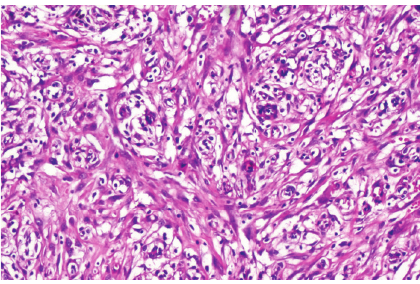
Figure 2: Proliferation of small caliber blood vessels with turgescent endothelial cells, surrounded by clusters of epithelioid cells, and associated with spindle cells proliferation.